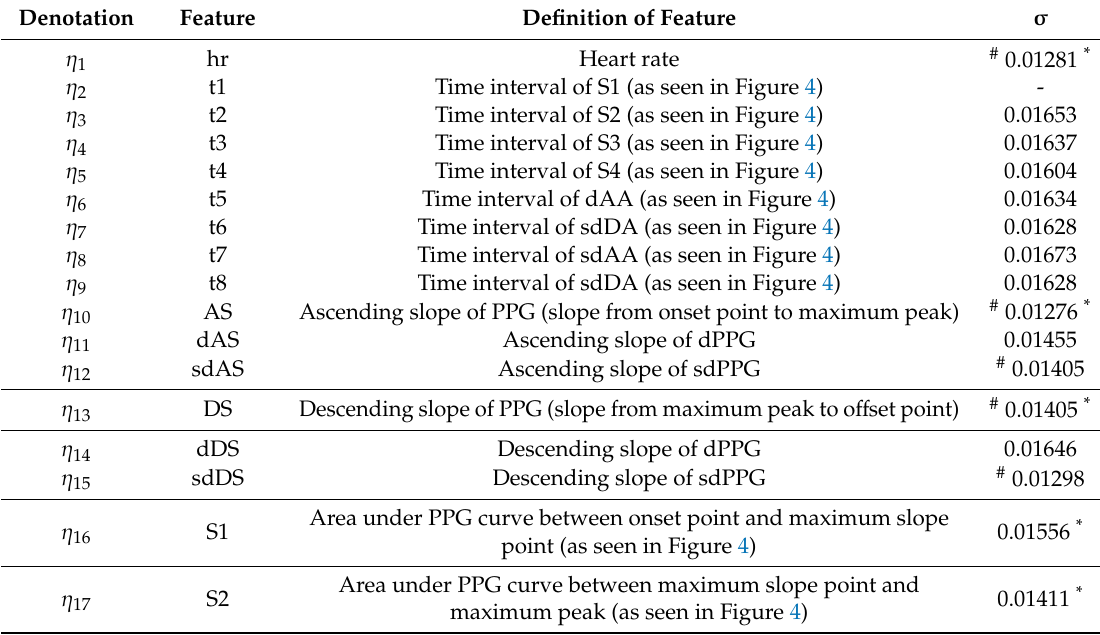
Table 1. Part of the PPG feature definitions and corresponding γ s are computed and listed in this table and all the definitions and denotations are in reference to past studies